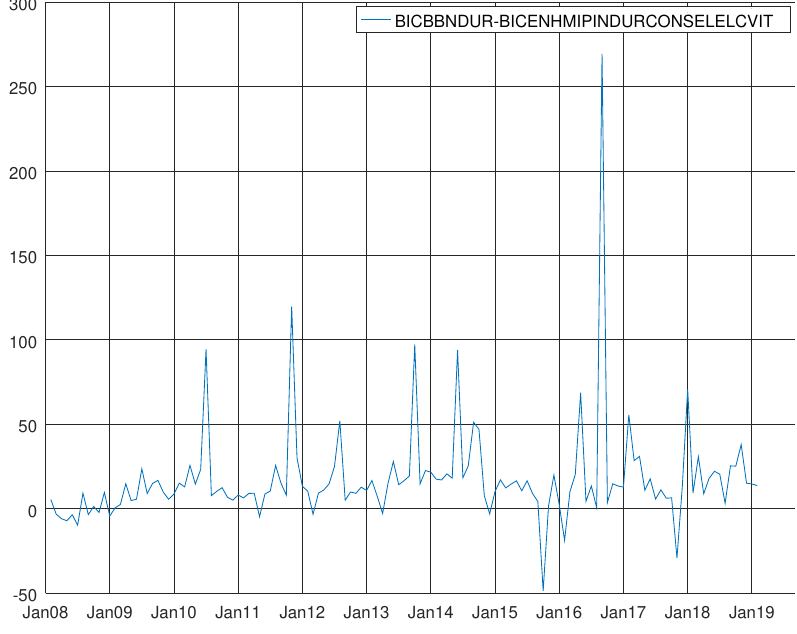
Figure 23. Graph showing the difference between the Bayesian information criterion of the barebone model and the enhanced model for non-durable